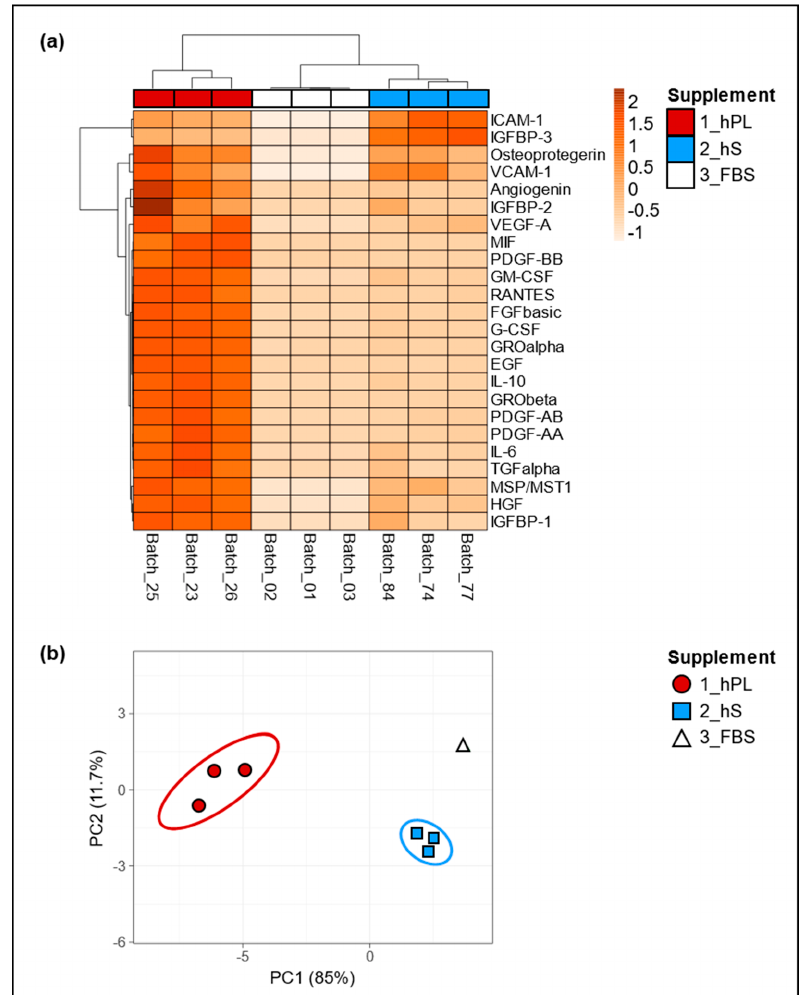
Figure 2. Secretome characterization of hPL, hS and fetal bovine serum (FBS) . Global differences in cytokine concentrations in supernatants from hPL, hS and FBS were compared and visualized by ( a ) unsupervised hierarchical clustering, where rows correspond to factors clustered using correlation distances and average linkage. Columns depict clusters using Euclidean distance and average linkage; ( b ) two-dimensional Principal Component Analyses (PCA) was carried out to determine associations between expression patterns of analyzed factors. hPL n = 3, hS n = 3 and FBS n = 3.